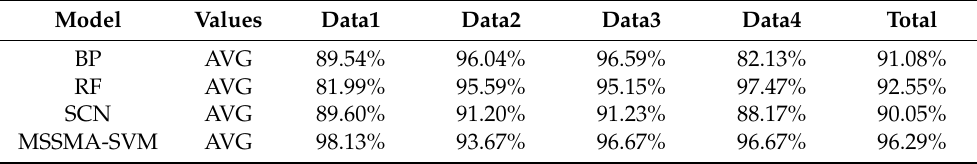
Table 5. The average accuracy using different algorithms.